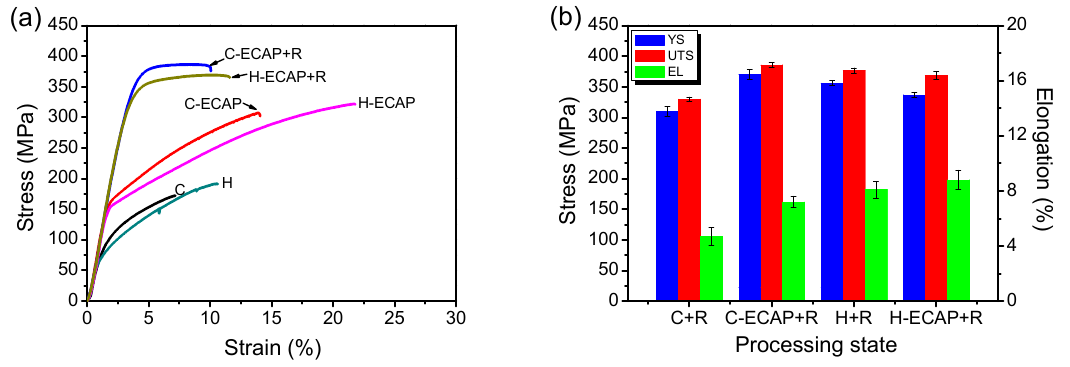
Figure 8. ( a ) Typical tress-strain curves of AZ91 alloys at di ff erent processing states; ( b ) the mechanical properties of C + R, C-ECAP + R, H + R and H-ECAP + R rolled samples.